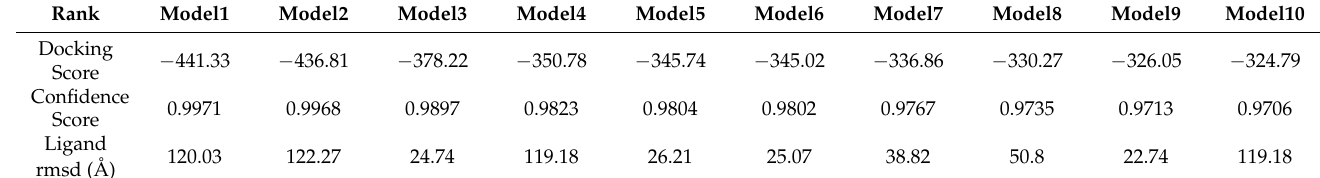
Table 3. The top 10 docking models between OsbZIP14 and OsbZIP58.